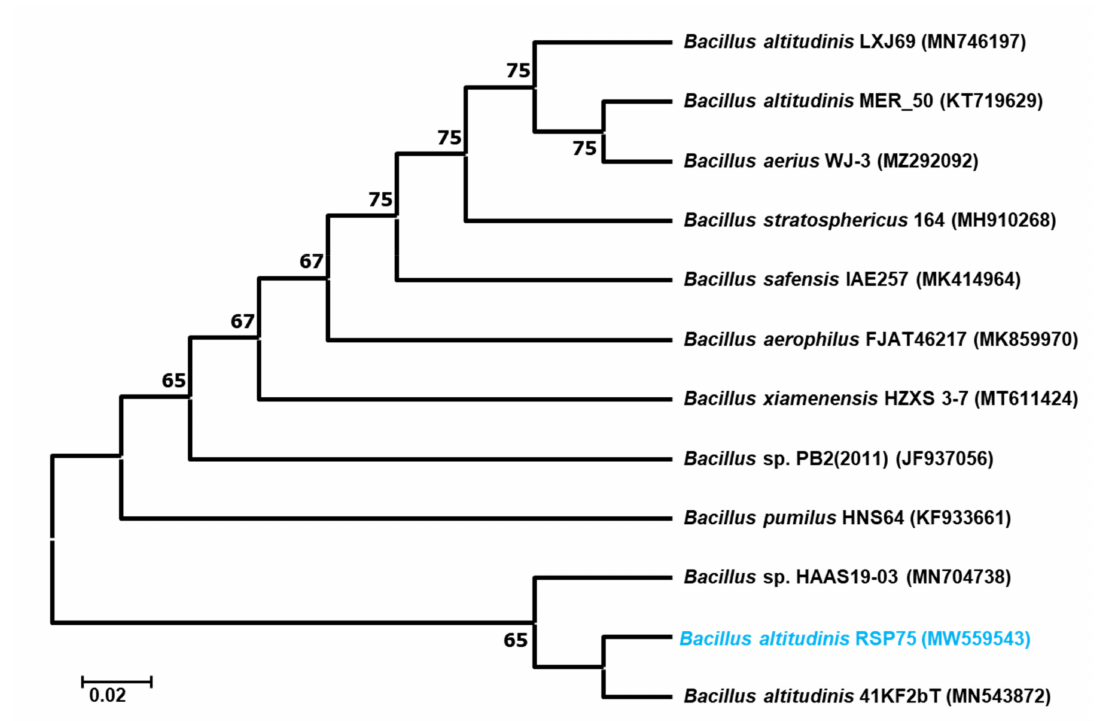
Figure 2. The phylogenetic reconstruction of B. altitudinis RSP75 generated by the neighbor-joining method in MEGA X, showing its relationships with closely related bacterial species from NCBI. Accession numbers are given in parentheses, and the bootstrap values are shown on nodes when above 60. Scale bar represents 0.02 Jukes–Cantor